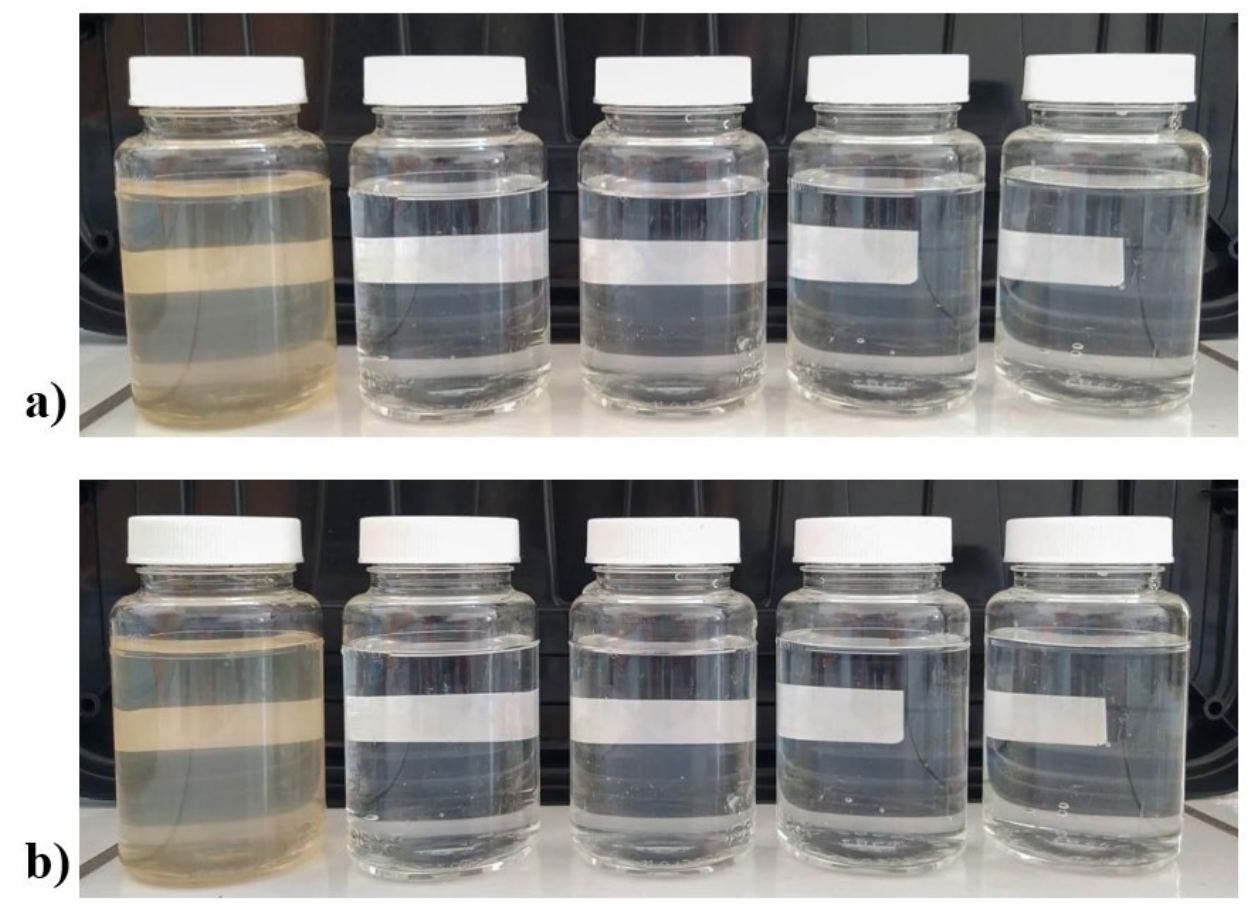
Figure 6. Digital photograph of flasks containing water treated with: ( a ) boehmite; and ( b ) Ag- Boehmite. First (left) flask not treated water, last flask water after 4th treatement.